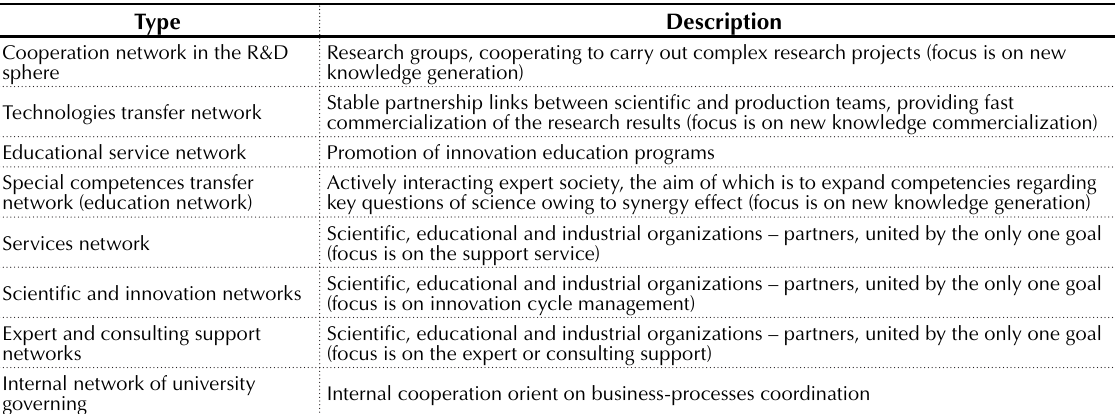
Table 2. Types of innovation